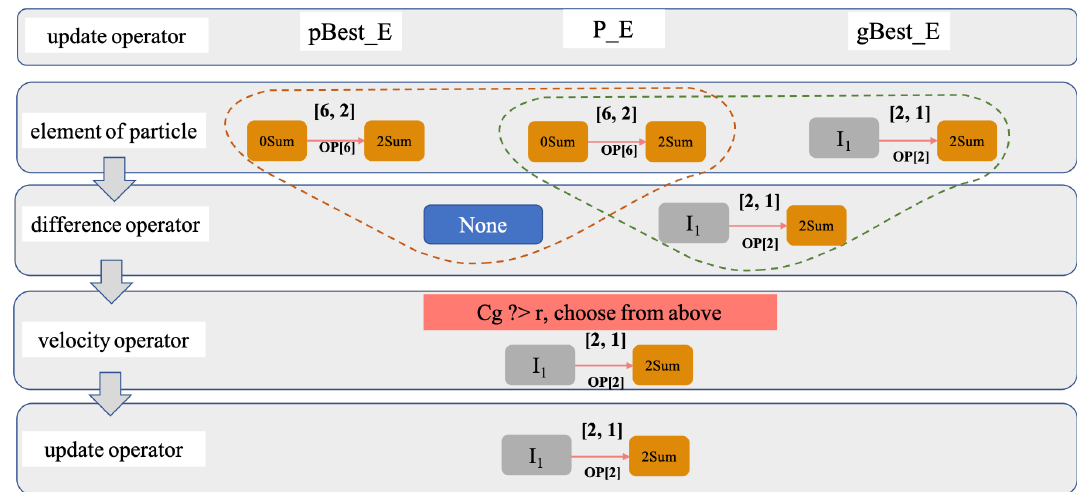
Figure 5. The update process for an element in a particle. This example shows an update of an element of the 2 nd intermediate node. Before being able to update the element of a particle, the difference between ( gBest _ E − P _ E ) or ( pBest _ E − P _ E ) by the different, and the velocity of the element needs to be computed using the velocity